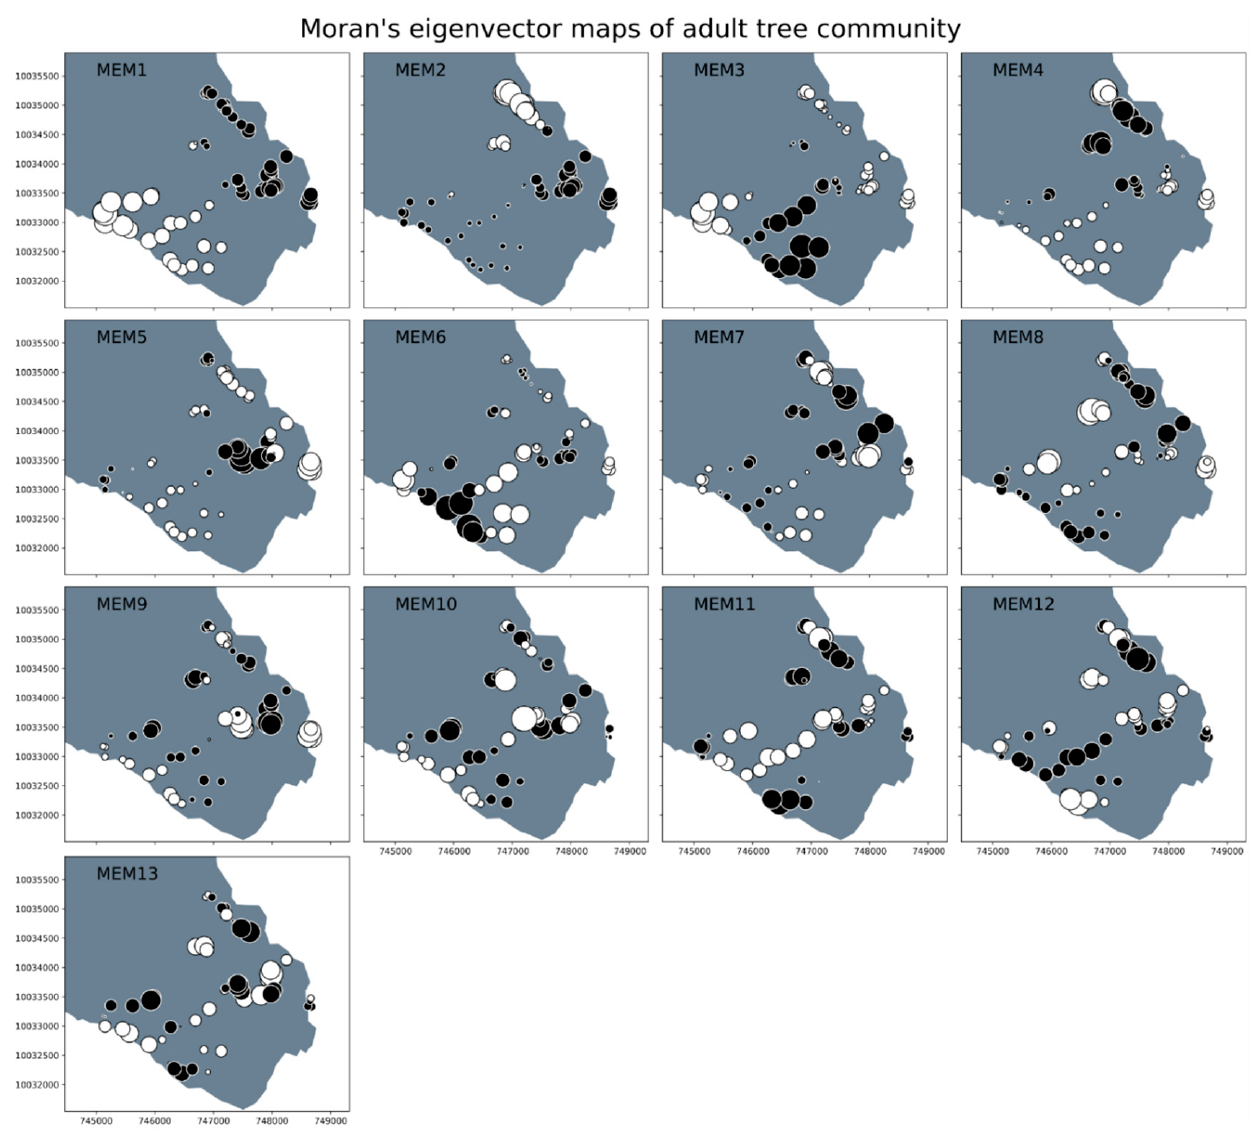
Figure 8. All statistically significant Moran’s eigenvector maps (MEMs) detected from tree community data. Within each map, two sites of large size but differing colors were maximally different (i.e., a site with a large white circle had some large difference in species composition with a site with a large black circle). Correlations between these spatial patterns and available environmental data are given in Table